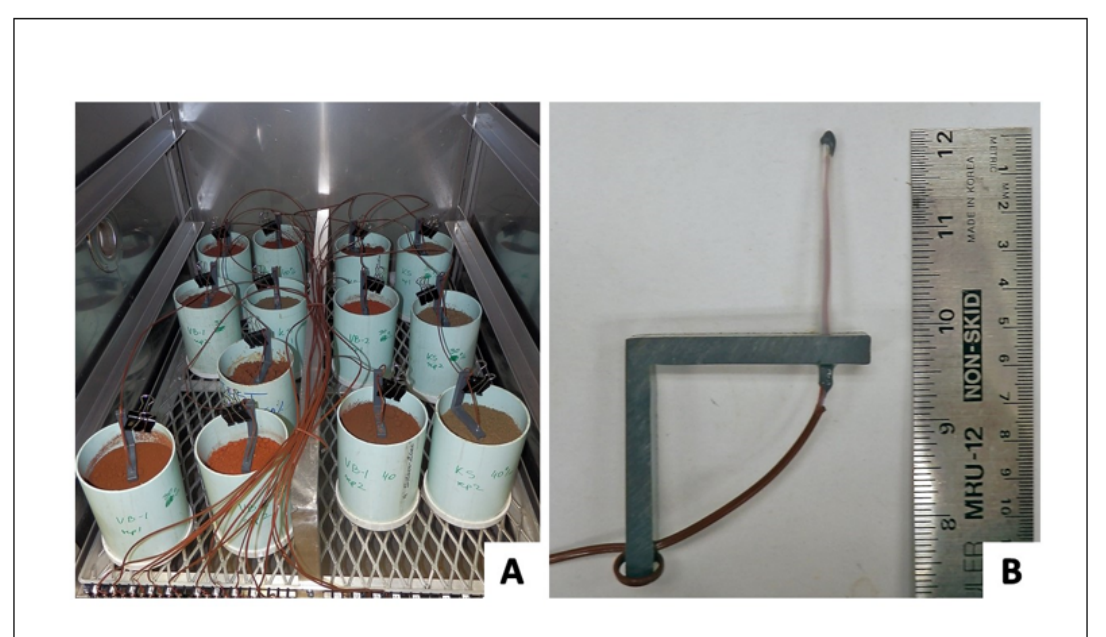
Figure 1. ( A ) Temperature-controlled chamber with containers filled with soil and thermocouples inserted at a depth of 5.08 cm (2 inches). ( B ) Close-up of thermocouple and bracket. Thermocouples were connected to a CR-7 datalogger (Campbell Scientific, Logan, UT, USA).